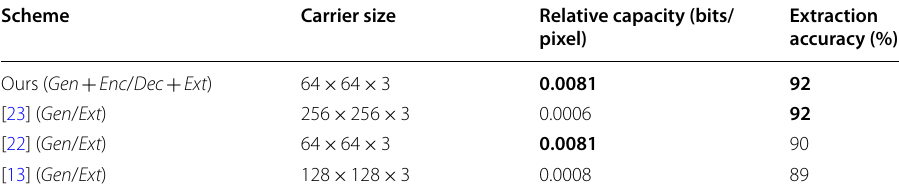
Bold values represent the best data in the comparison term